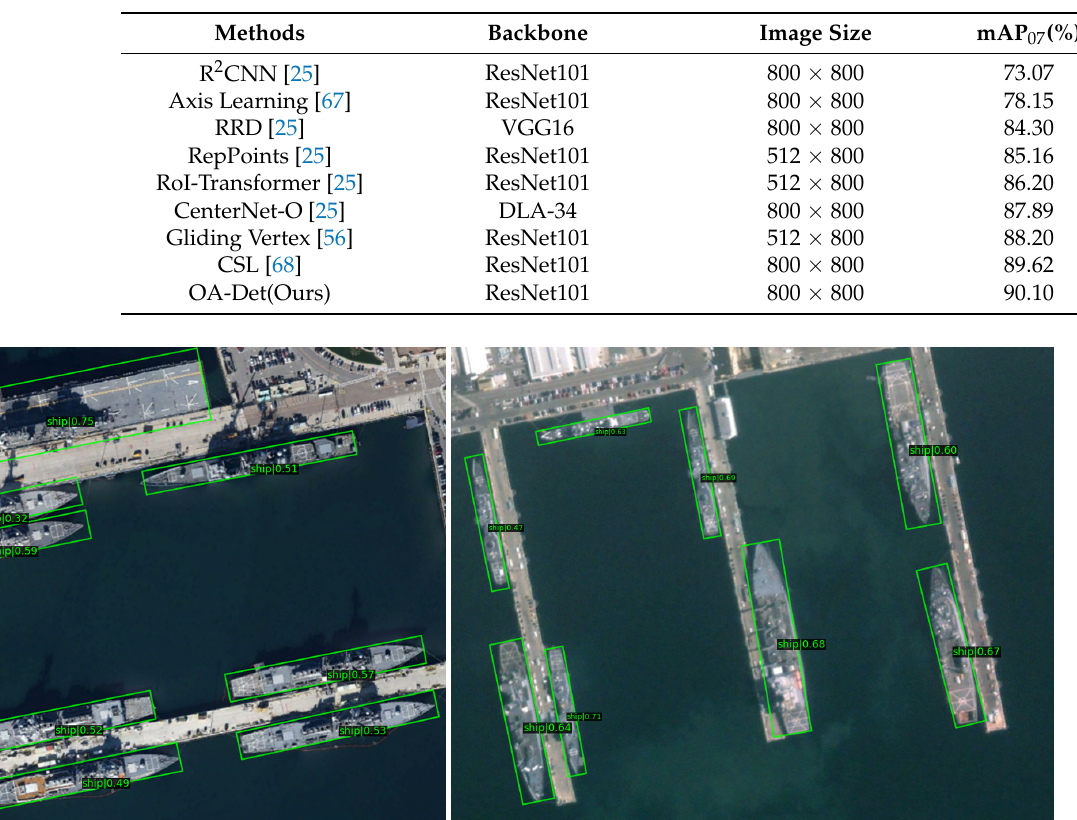
Table 8. Comparisons with high-quality detection performance on HRSC2016 dataset: mAP 07 indicates the results under VOC2007 mAP metrics.